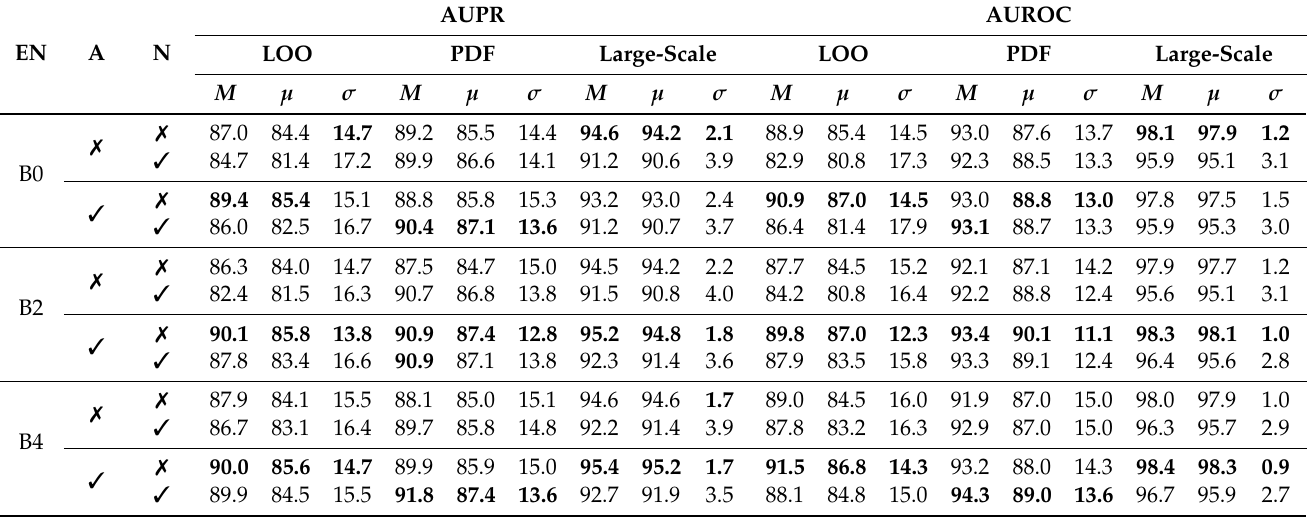
Table 8. Are models that generalize better synergetic to post hoc adaptation methods? Scores on the held-out fabrics and on the test set of the large-scale dataset used for model training are reported for pre-trained models fine-tuned with HSC loss and with or without application of AugMix. Furthermore, models are trained with or without addition of normal data from the held-out fabric to the large-scale dataset used for training (N). In addition to the performance of the learned decision boundary on the held-out fabric (LOO), we also report the performance of the model when subjected to post hoc adaptation as proposed in [21] (PDF). Dataset B is used for training, and best scores within each model are highlighted in bold. Abbreviations: EN = EfficientNet; A =